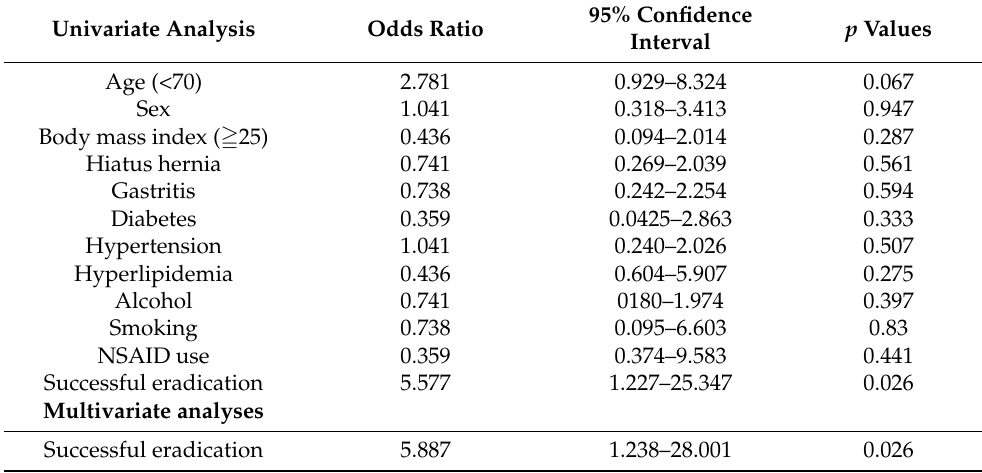
Table 3. Univariate and multivariate